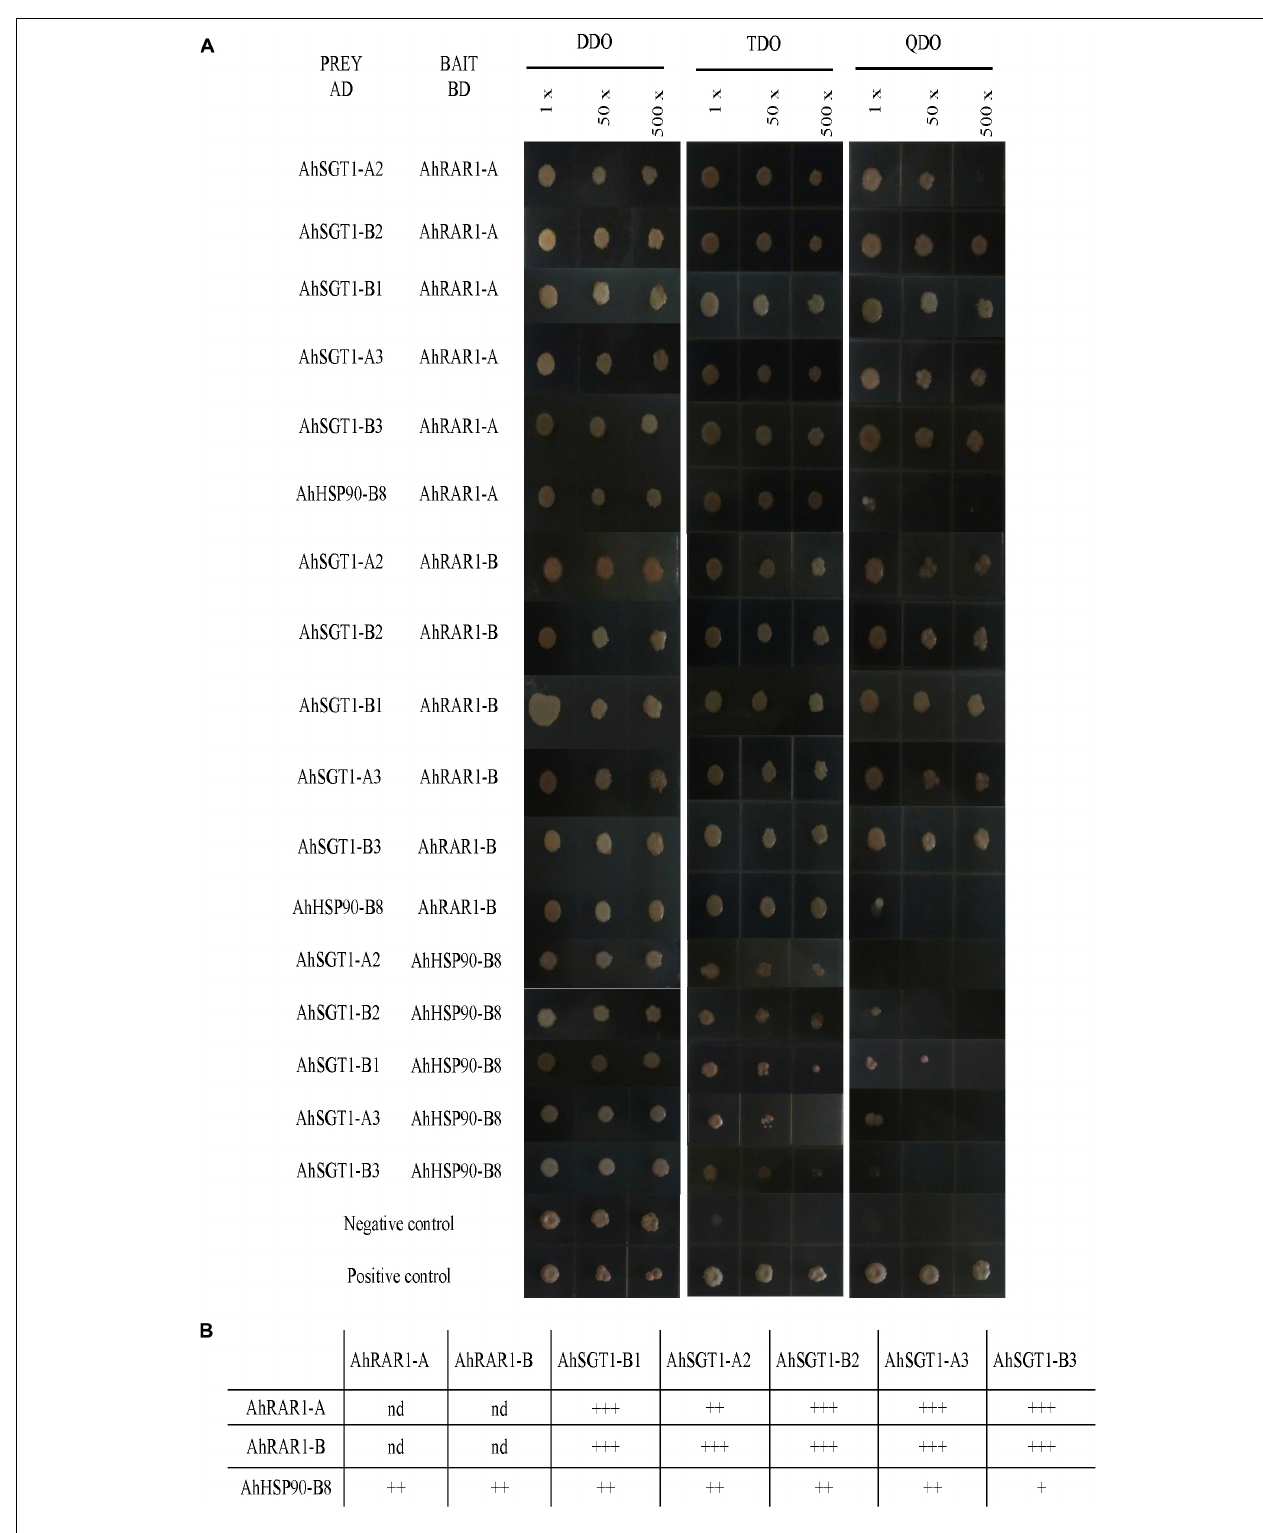
FIGURE 10 | Pairwise interactions among HRS proteins. (A) Positive interactions were identified based on yeast growth in TDO and/or QDO media. The yeast inoculums were progressively diluted and used as the original resuspension (1 × ), 50-fold dilution (50 × ), or 500-fold dilution (500 × ). (B) Schematic representation of the HRS complex in peanut. The number following “+” represents the strength of the protein-protein interaction. nd: not detected.